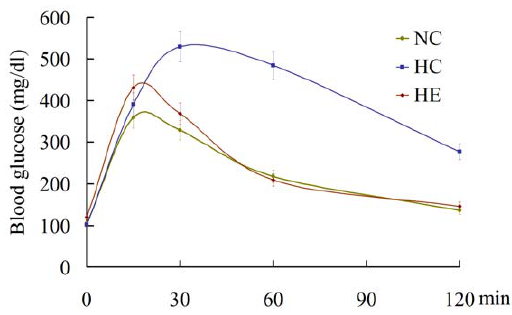
Figure 2. Evaluation of glucose tolerance by OGTT. Oral glucose tolerance test was performed in each group (n=6) of mice after 6 weeks of aerobic exercise. Values are means 6 SEM. NC=normal chow control; HC=HFD control; HE=HFD exercise.